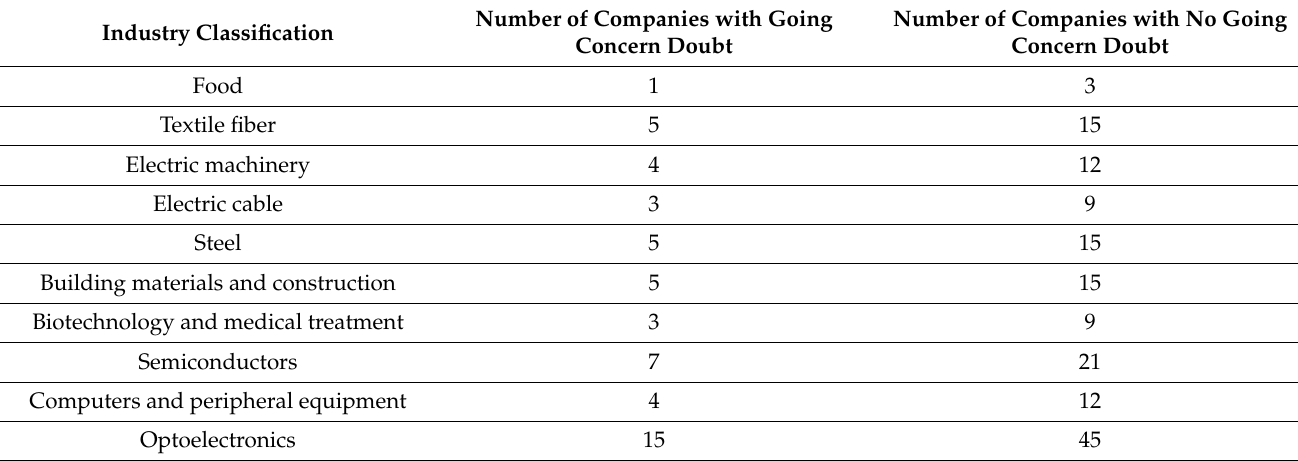
Table 1. Sample Table 1. Sample distribution.